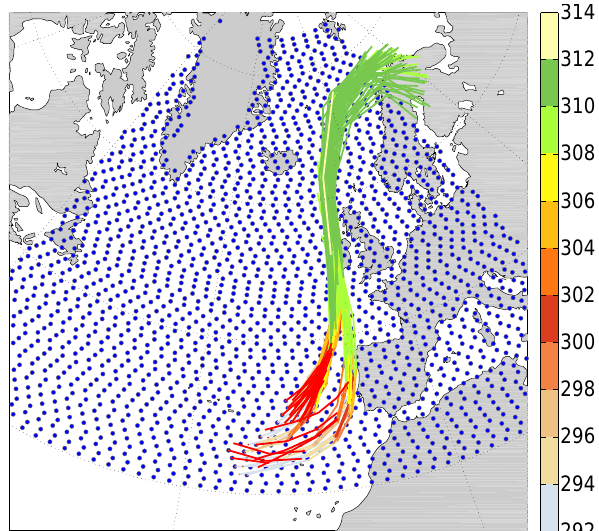
Figure 1. Lagrangian identification of a warm conveyor belt (WCB). Two-day forward trajectories are started at 12:00UTC on 29 January 2009 over the North Atlantic between 1030 and 790hPa every 30hPa. The starting points are equidistantly dis- tributed (80km horizontal spacing; blue dots). Trajectories ascend- ing more than 600hPa within 48h are selected as WCB trajectories and colored according to potential temperature (in